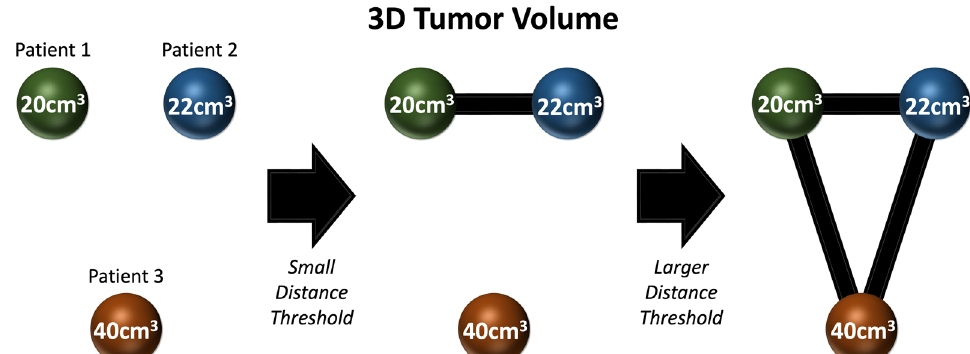
Fig. 1 An example of three patients with varying 3D tumor volumes within a two-dimensional point cloud. The point from patient 1 and patient 2 for 3D tumor volume is close, therefore only requiring a small distance threshold to create a simplicial complex. As the distance threshold is expanded, the simplicial complex can include additional points with increasing